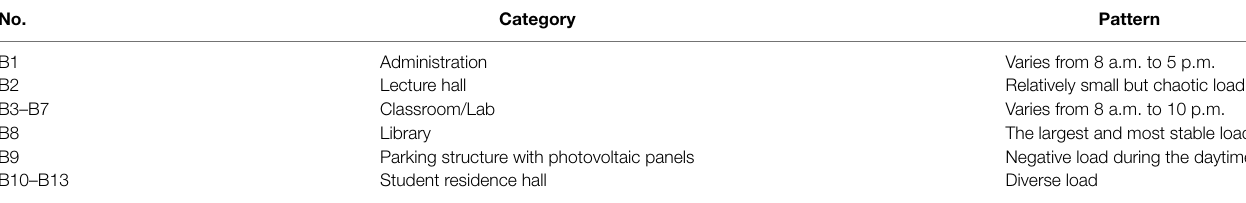
TABLE 1 | Building categories and energy load patterns.